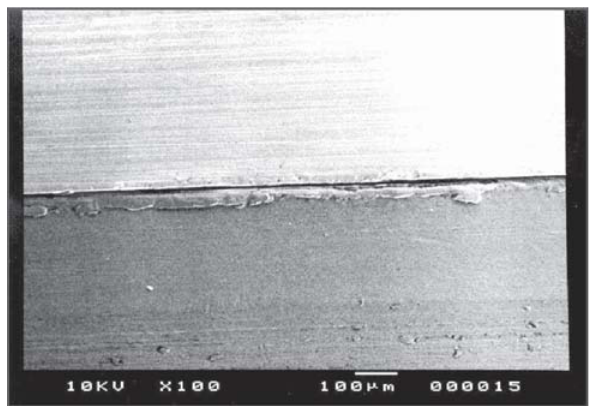
FIGURE 4A- Scanning electron microscope, gold cylinder